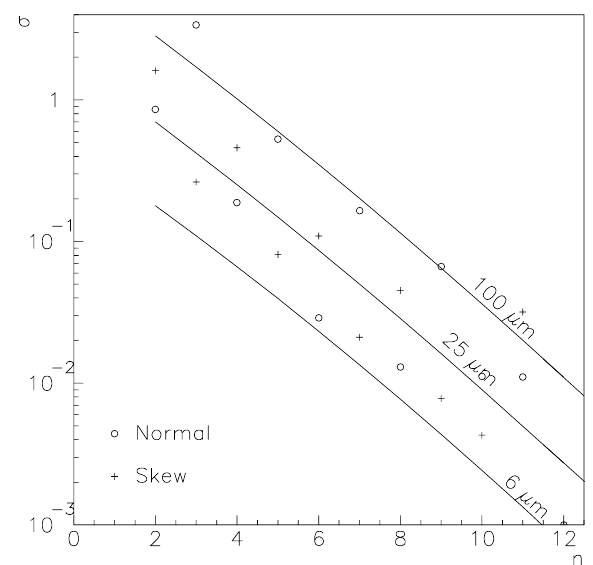
FIG. 5. rms of the multipole averages for the first four LHC dipole prototypes (markers) and scaling law for different ampli- tudes of random displacements d (solid